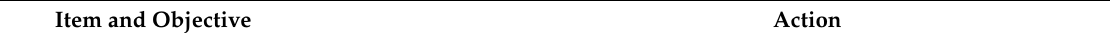
Table 3. Ensuring continued access to sexually transmitted infection prevention and HAART services at the community level during the COVID-19